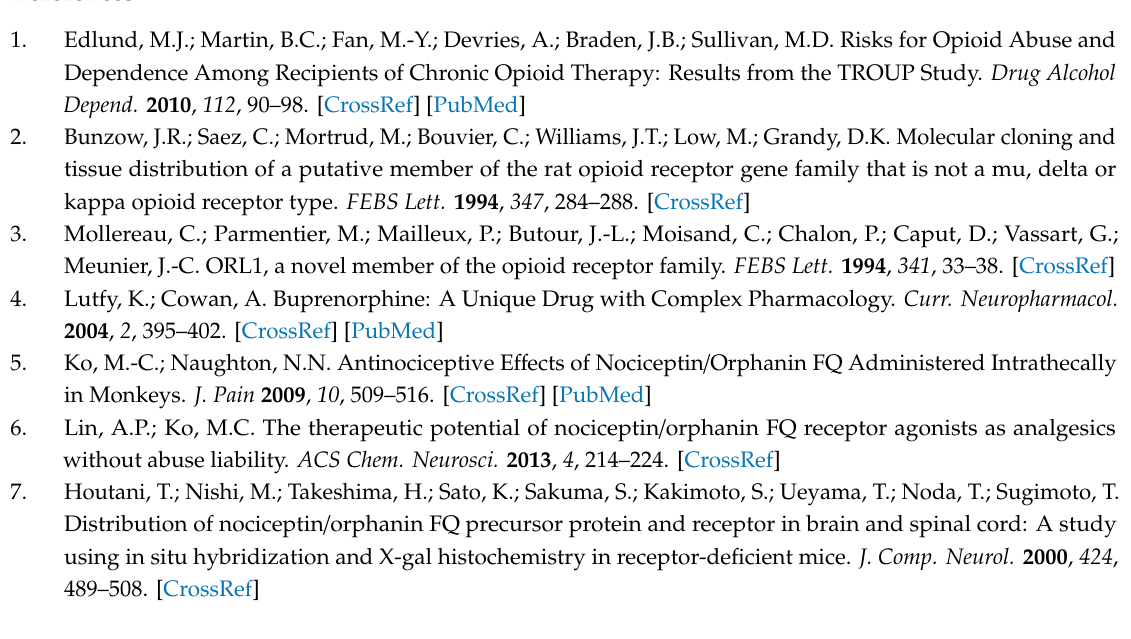
Figure S1: Activation of mERs attenuated NOP-mediated tactile antihypersensitivity via an ERK-, PKA-, PKC-, and Akt-independent